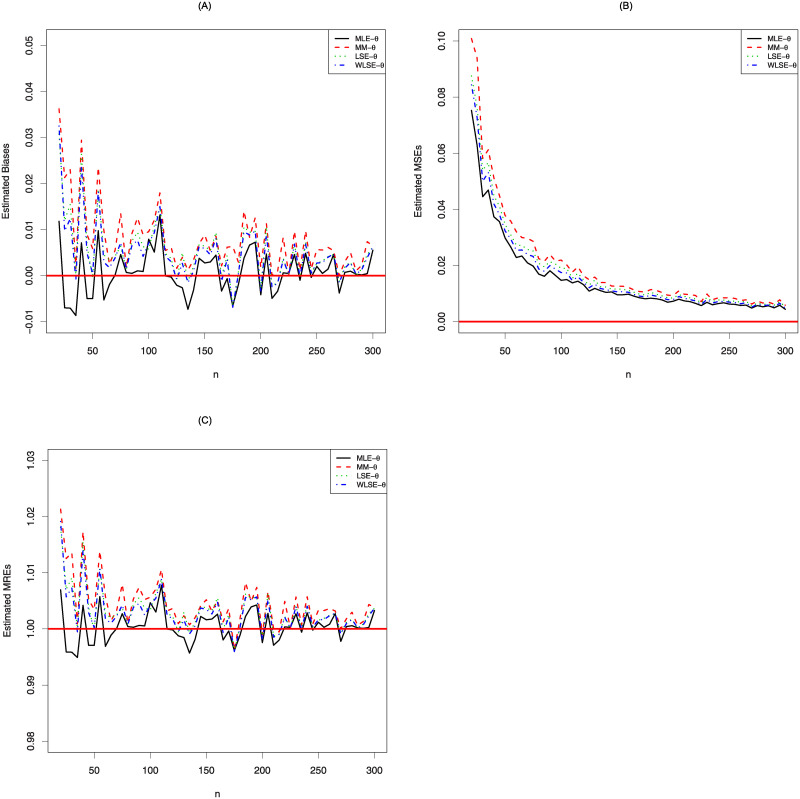
The simulation results of the log-Bilal distribution.